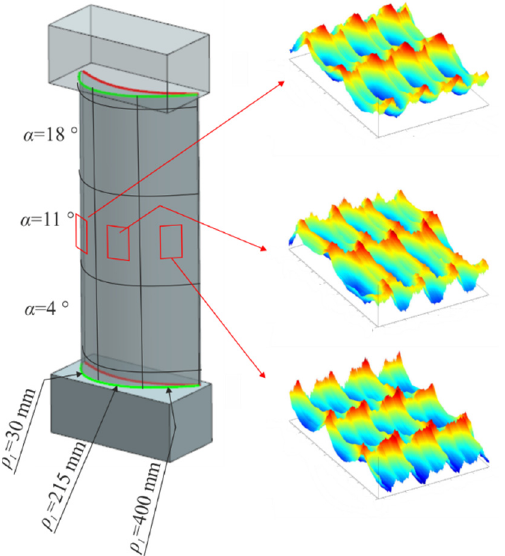
Figure 25. Topography of the convex surface when changing the curvature radius for the lead angle α = 11°.